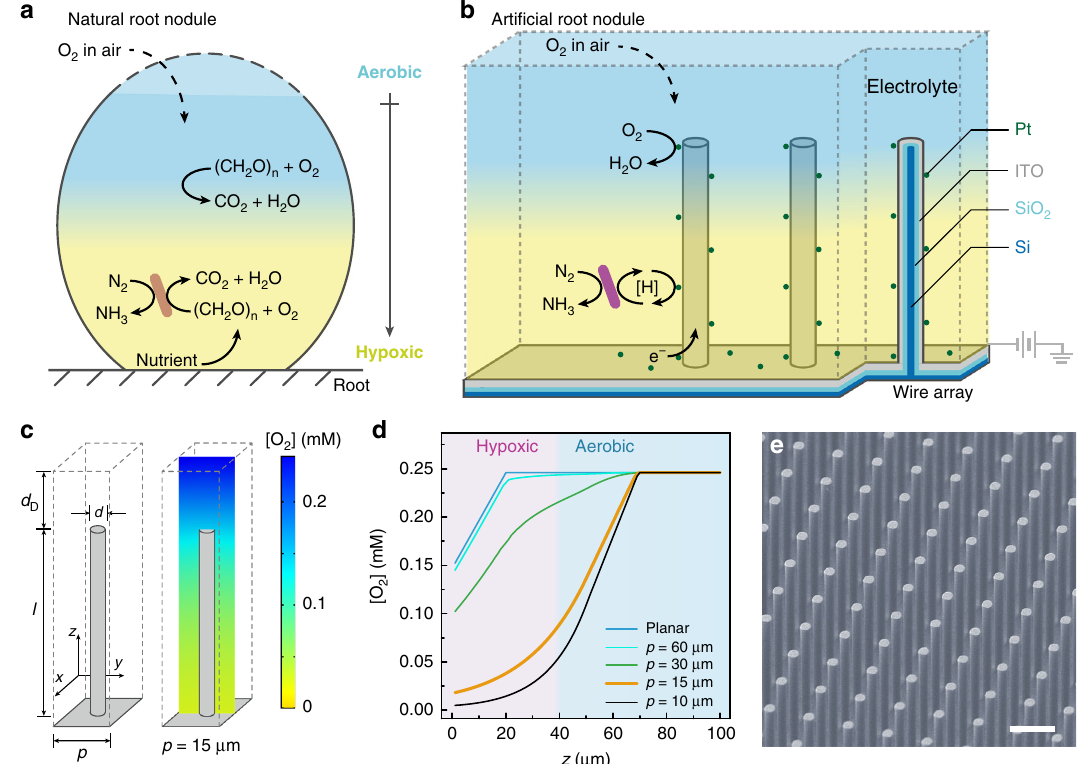
Fig. 1 Scheme and the simulated O 2 gradient of electricity-driven arti fi cial root nodule. Scheme of N 2 fi xation in the natural a and the proposed arti fi cial root nodule b . c Morphology of designed microwire array and the cross-sectional display of simulated O 2 concentration ([O 2 ]) pro fi le. Length ( l ), 50 μ m; diameter ( d ), 4 μ m; periodicity ( p ), 15 μ m; diffusion layer thickness ( d D ), 20 μ m. d Simulated [O 2 ] against the distance from the base of electrode ( z ) for planar electrode and microwire arrays of different p values ( l = 50 μ m, d = 4 μ m). The hypoxic (pink) and aerobic (blue) domains for wire array of p = 15 µ m are suggested. e Scanning electron microscopy (SEM) image of the prepared Si wire array with a morphology shown in c . ITO indium-tin oxide. Scale bar, 15 μ m. Electrochemical potential ( E appl ) = 0.5 V vs. reversible hydrogen electrode (RHE) in c and d